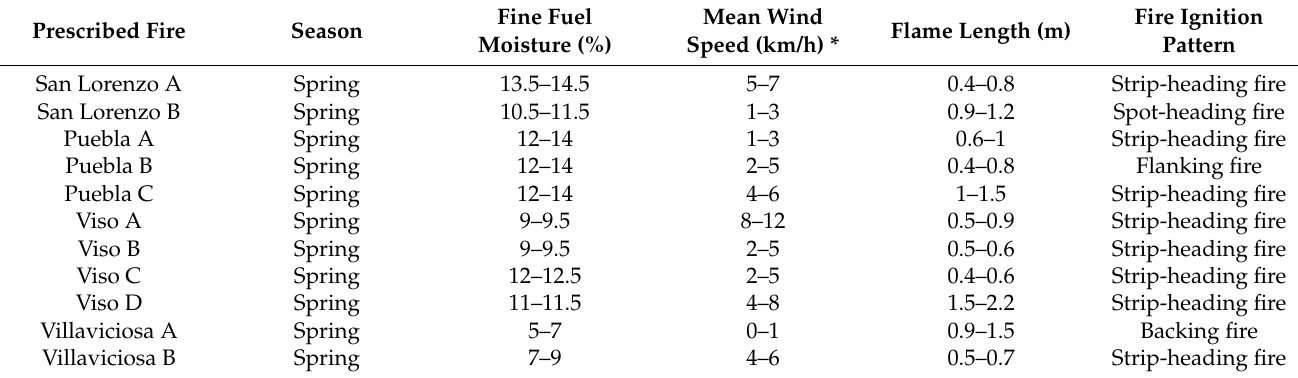
Table 1. Characterization of environmental conditions, flame length, and fire pattern for each